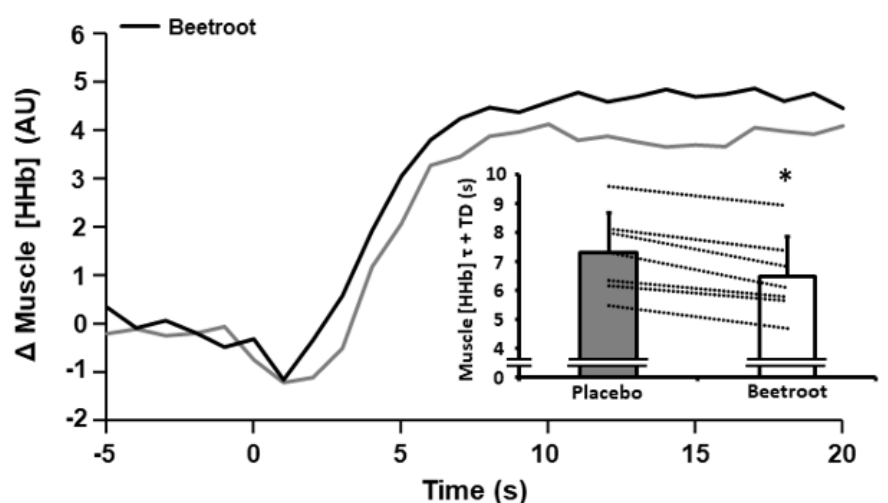
Figure 3. Muscle deoxyhaemoglobin + deoxymyooglobin concentration ([HHb]) response profiles during the initial stages of a 60 s end-sprint following 2 h moderate-intensity exercise after ingestion of nitrate-depleted beetroot (placebo) and nitrate-rich beetroot (beetroot) powder in a representative individual. Data are expressed as the change ( ∆ ) from baseline. Inset illustrates muscle [HHb] time constant ( τ ) + time delay (TD) after ingestion of placebo (grey bar) and beetroot (open bar) powder. Dashed lines represent individual responses. Data presented as mean ± SD. * indicates significantly higher than placebo ( p < 0.001).